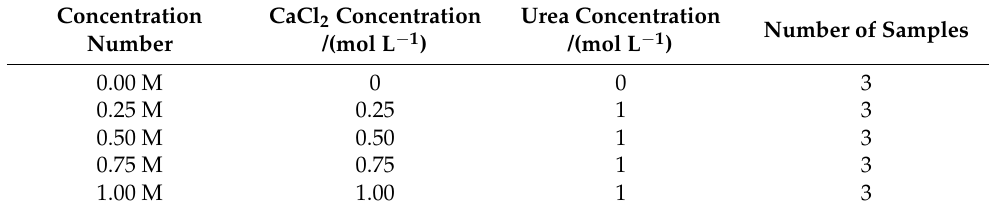
Table 2. Sample number and cementation